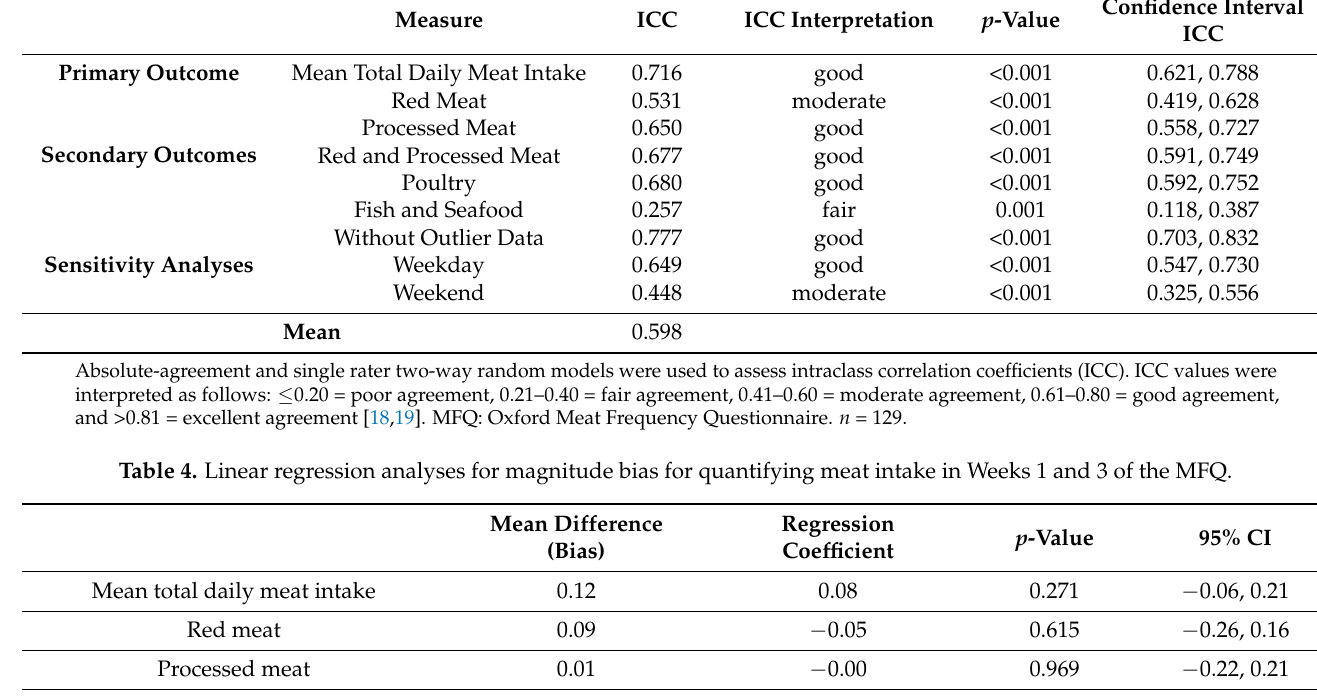
Table 3. Intraclass correlation coefficients (ICC) between daily mean intakes of meat assessed by Weeks 1 and 3 of the MFQ. Measure ICC ICC Interpretation p -Value